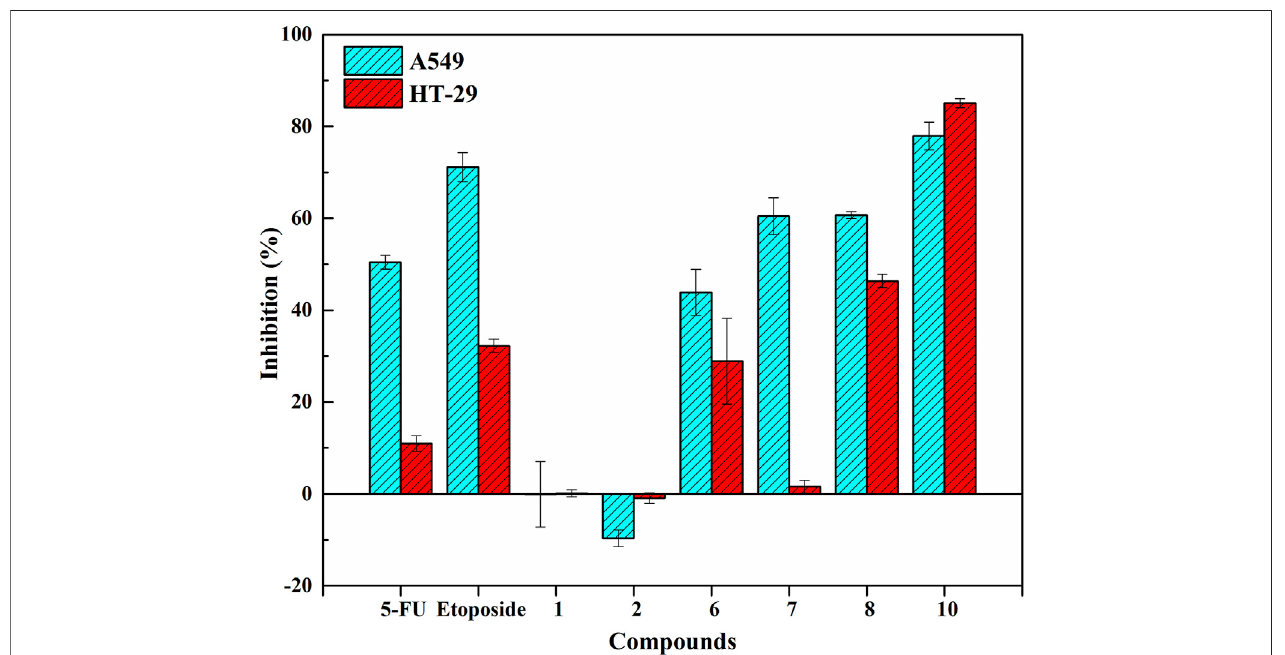
FIGURE 4 | Inhibitory effects of these selected components and two positive drugs on A549 and HT-29 cells.